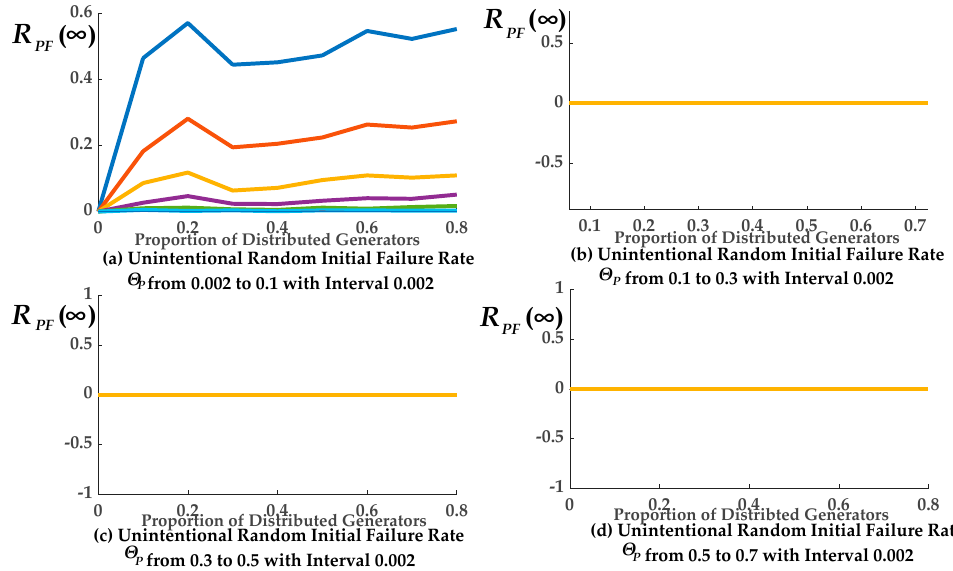
Figure 5. The final expected proportion of normal operational nodes in the power network (PN) after the CCF stops ( R PF ( ∞ )) of different distributed generators proportions in the PN with Erdos–Renyi (ER) topological structure.